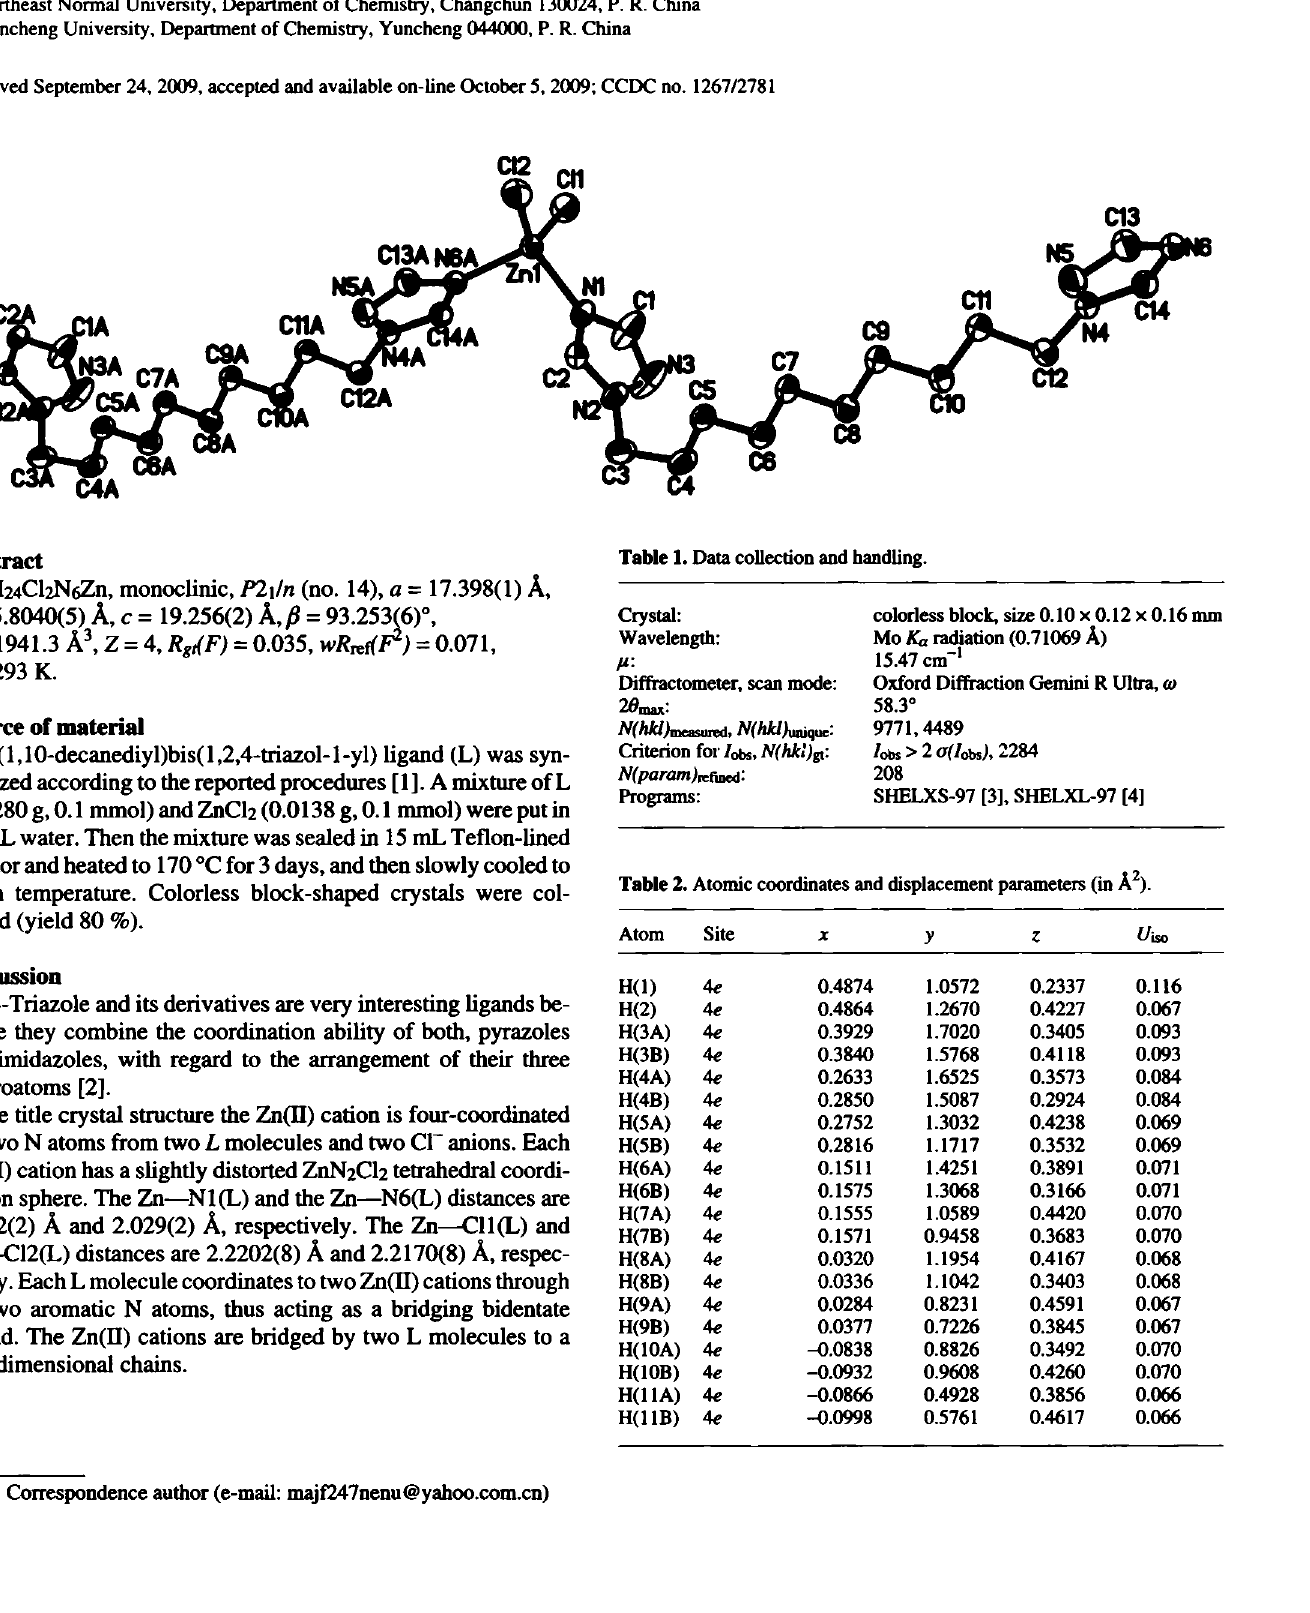
Table 1. Data collection and handling.